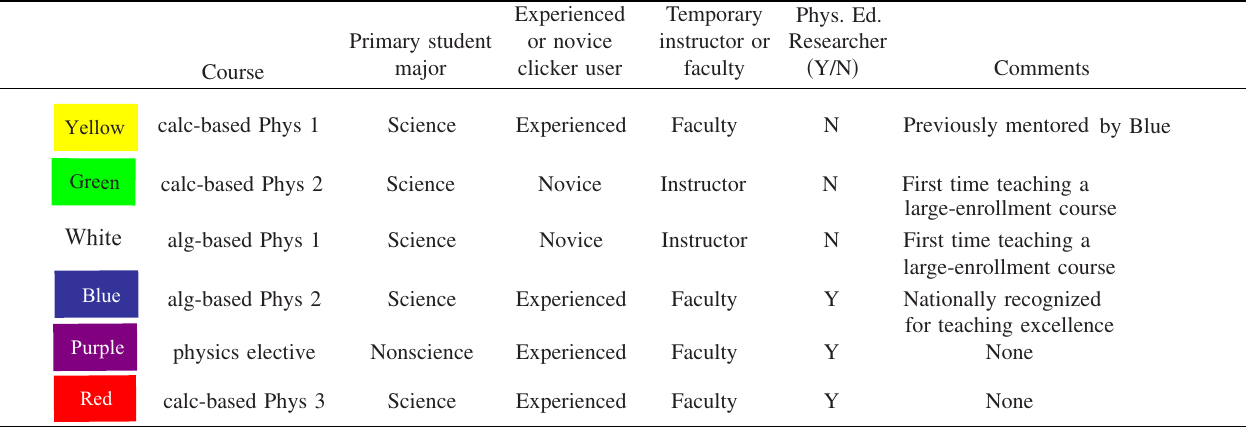
TABLE A. Course and professor